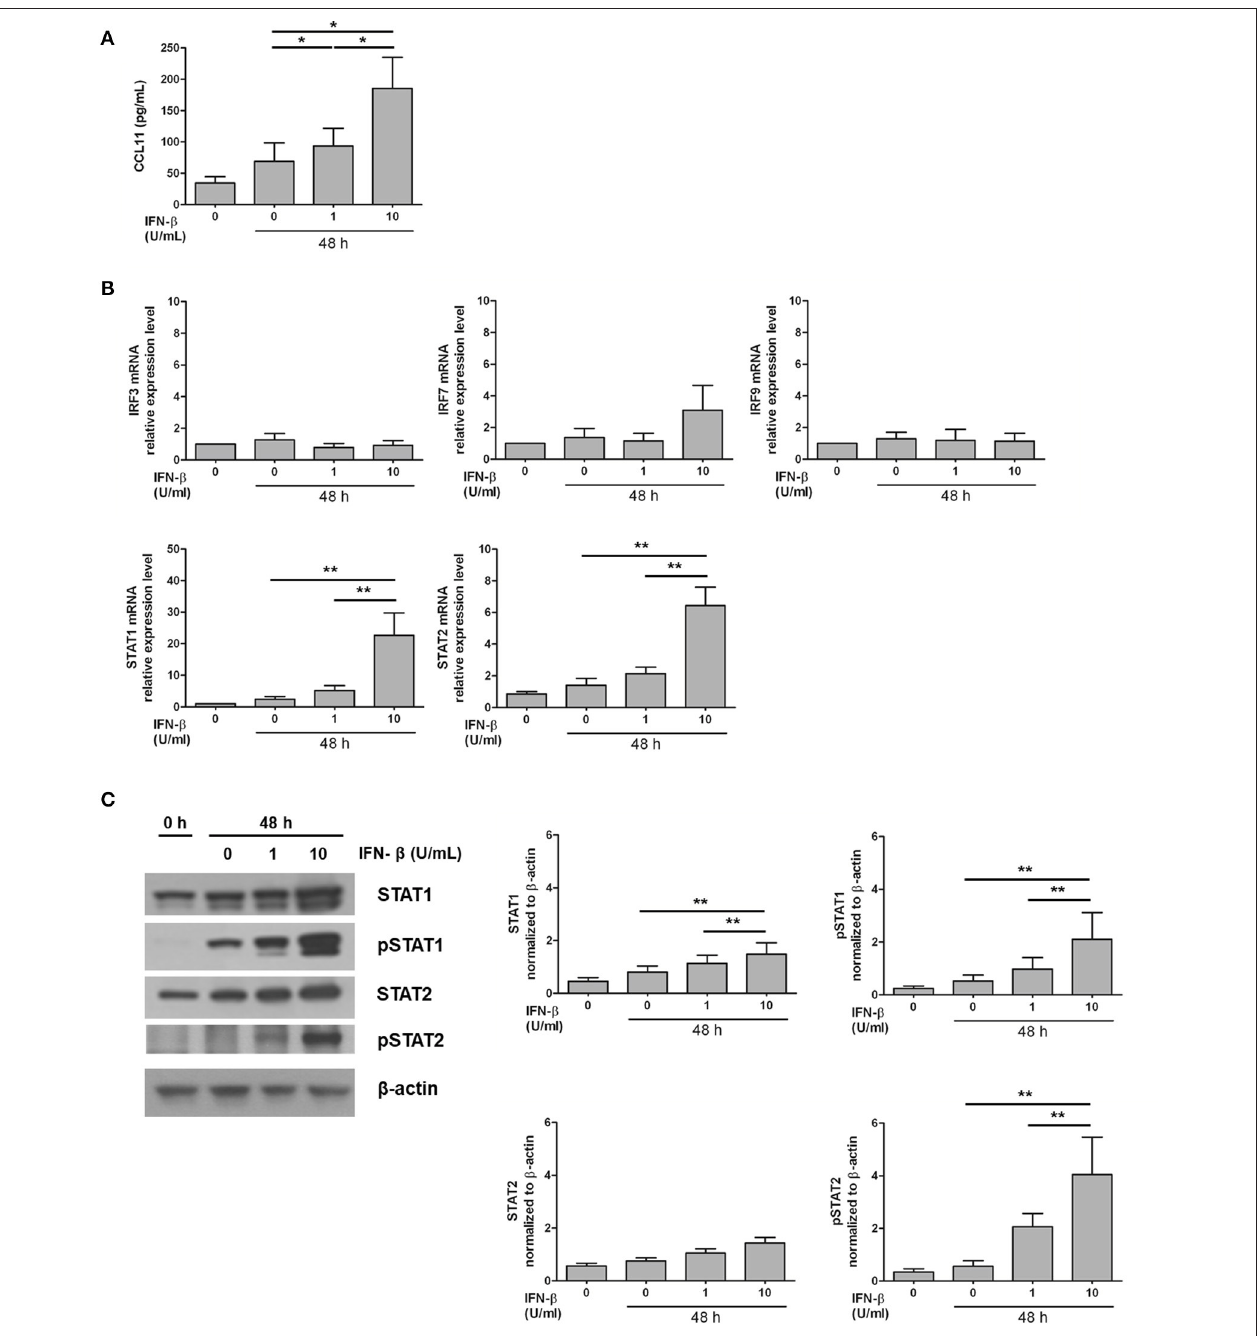
FIGURE 5 | Induction of the expression of CCL11 and transcription factors by exogenous administration of IFN- β in NP stromal cell culture model. (A) The production of eosinophil chemokine CCL11 was increased by IFN- β stimulation in NP stromal cells in a dose-dependent manner. (B,C) In addition, STAT1 and STAT2 mRNA expression and STAT1, pSTAT1, and pSTAT2 protein expression were enhanced by IFN- β stimulation in NP stromal cells. * P < 0.1; ** P < 0.01, repeated measurement ANOVA with the non-parametric Friedman’s